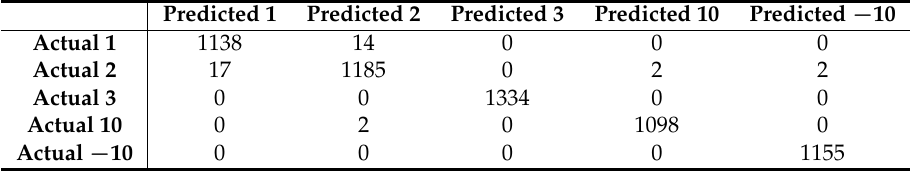
Table 6. 10-fold cross-validation results of the GBT classifier for activity